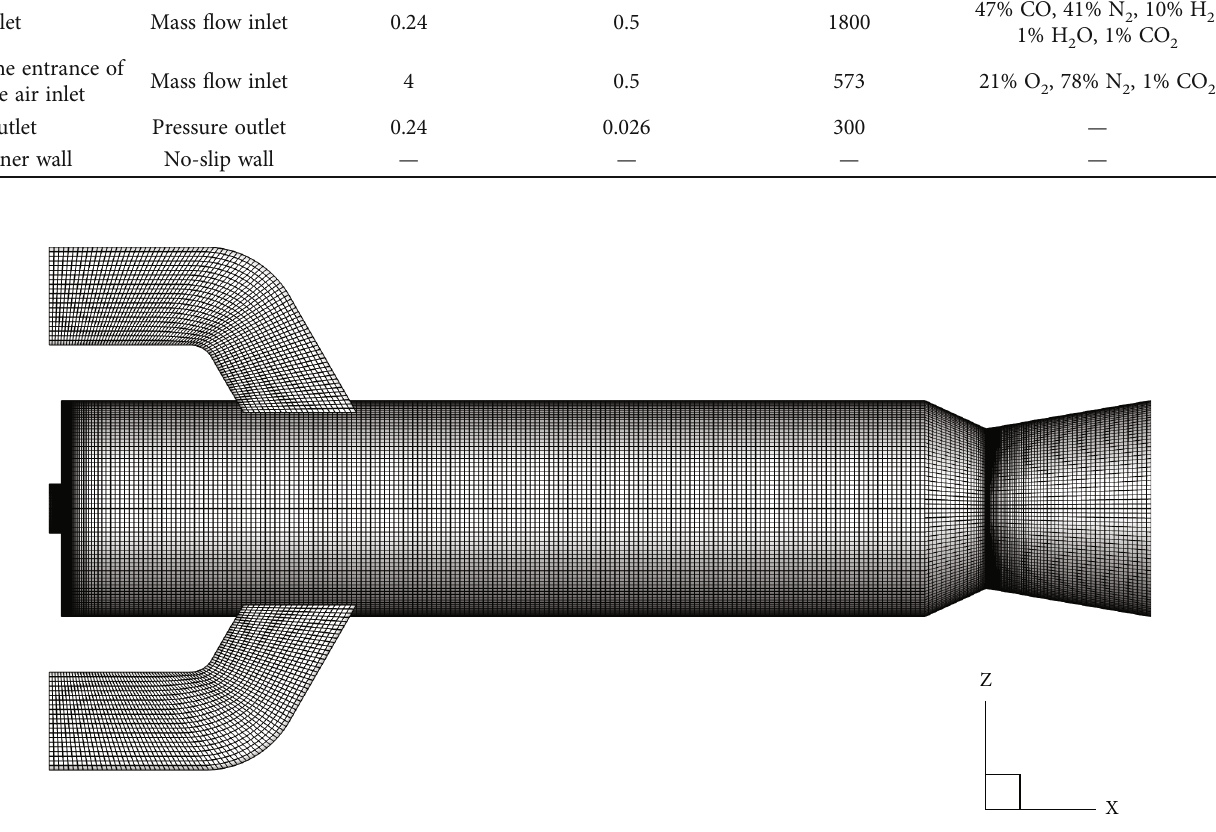
Figure 2: Grid applied in computational fl uid